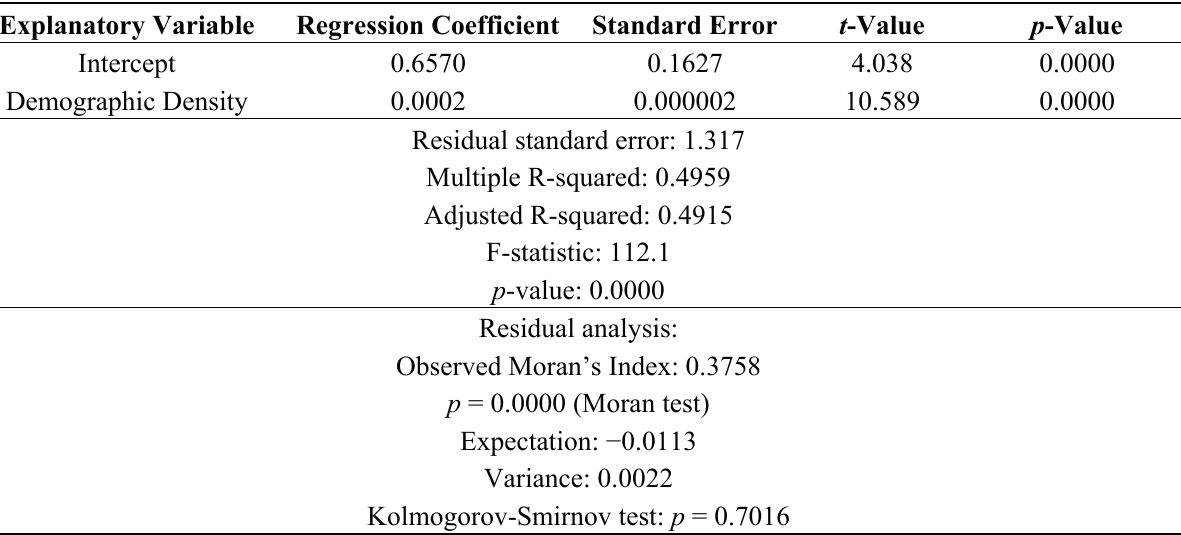
Table 3. OLS regression model: Rome, total VRU traffic accidents.